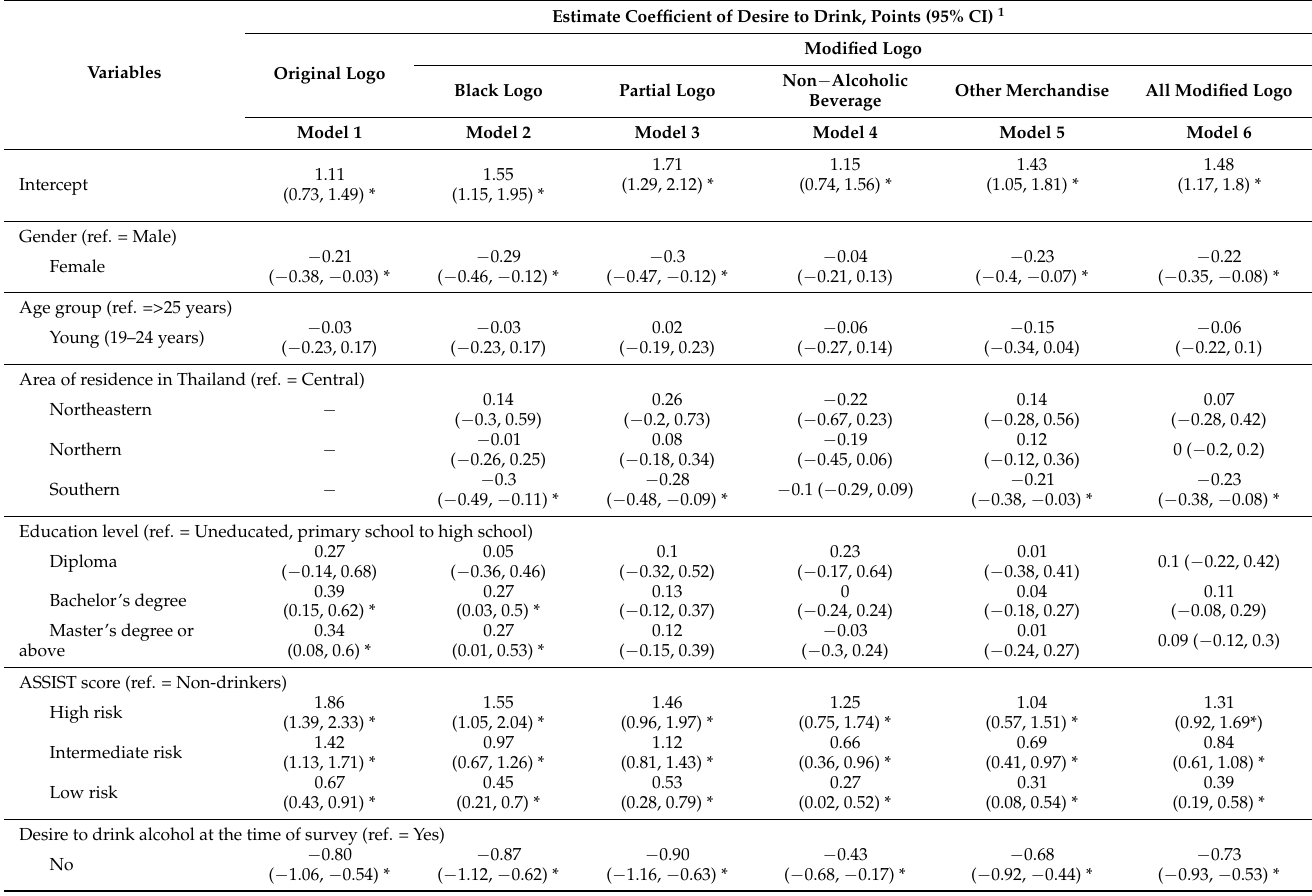
Table 4. Subgroup analysis of score of desire to drink after seeing each type of